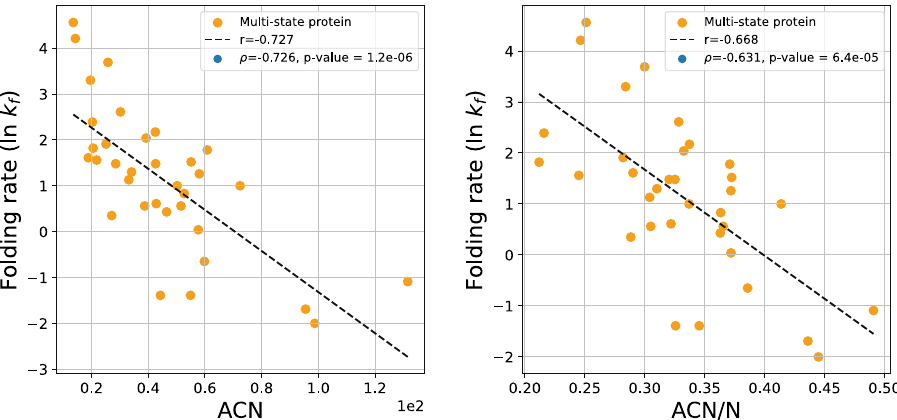
Figure 10. The protein folding rate as a function of the ACN and ACN/N of the set of multi-state proteins.